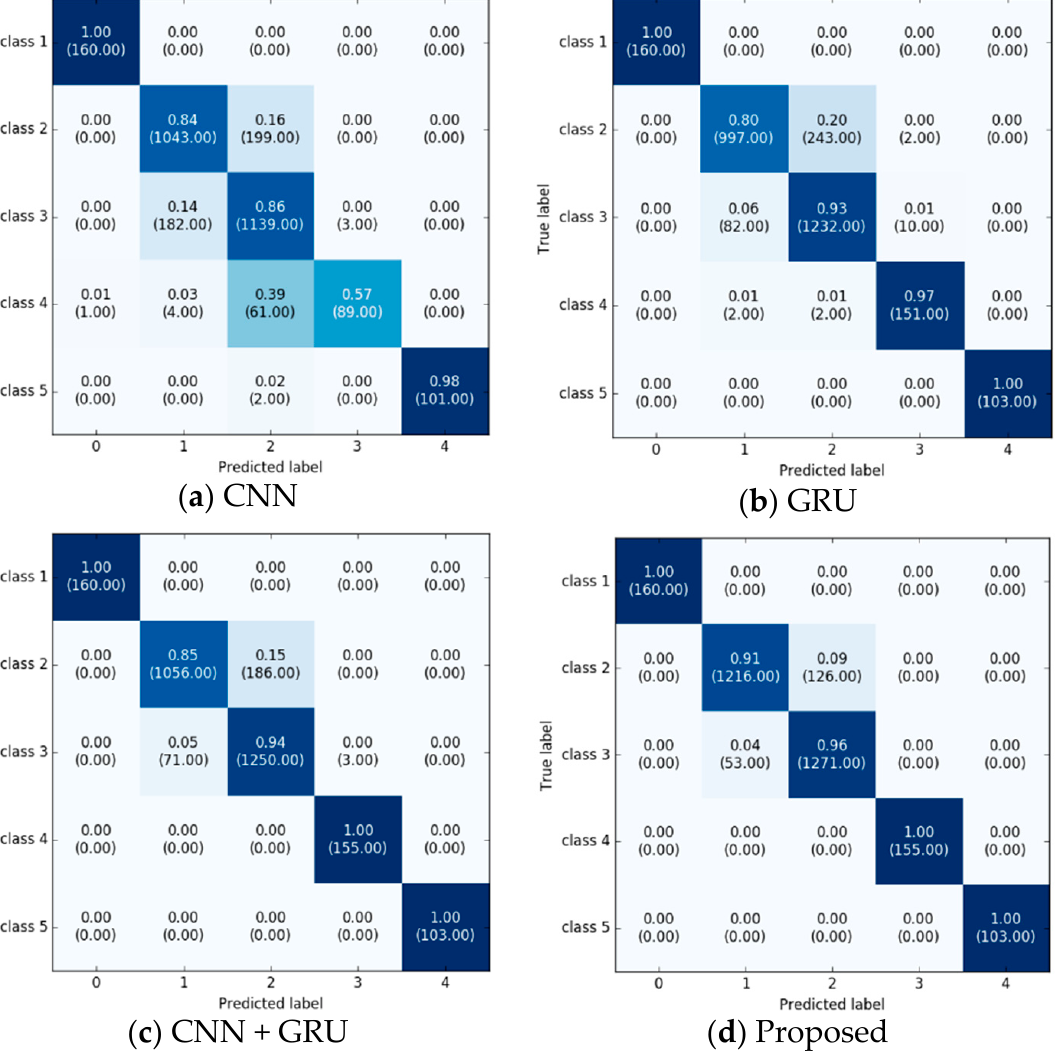
Figure 6. Confusion matrix with normalization for classification results of Table 3. The number of samples predicted for corresponding class is presented in the parentheses. ( a ) Represents the result of CNN; ( b ) shows the result of GRU; ( c ) is the result of basic hybrid CNN and GRU model; ( d ) represents the result of our proposed model.